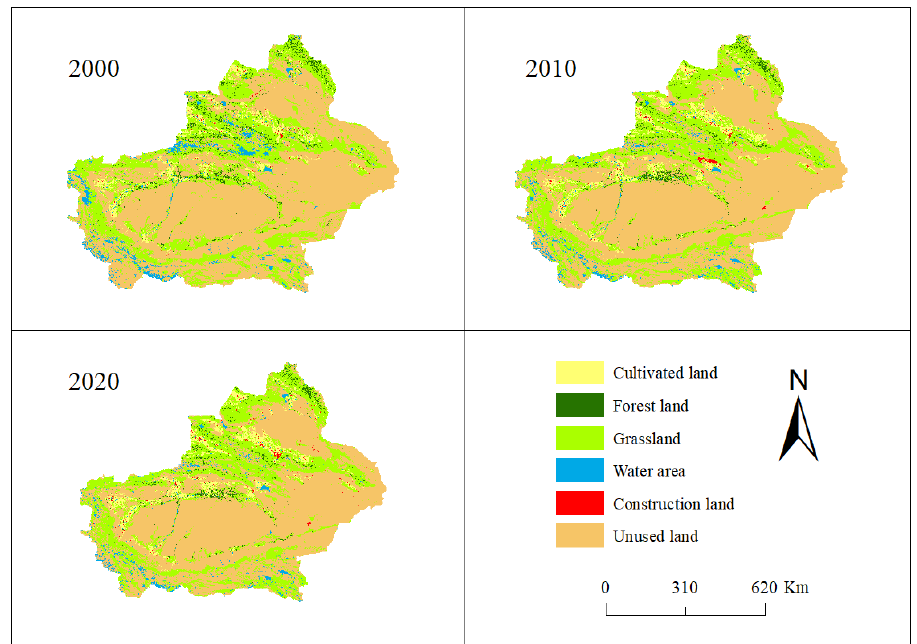
Figure 3. Land use types in Xinjiang in 2000, 2010 and 2020. Table 2. Land use situation in Xinjiang in 2000, 2010, and 2020.